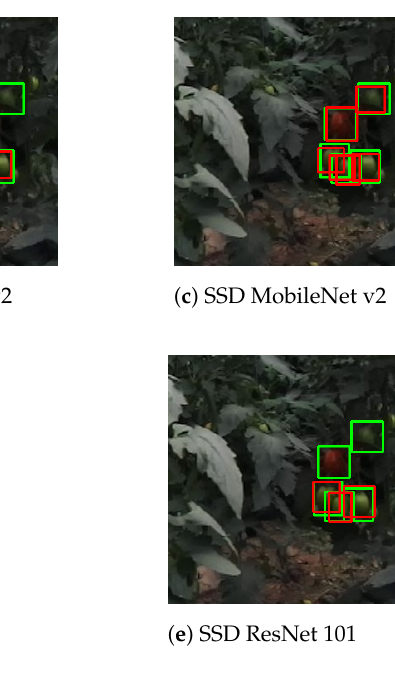
Figure 14. Result comparison for darkened